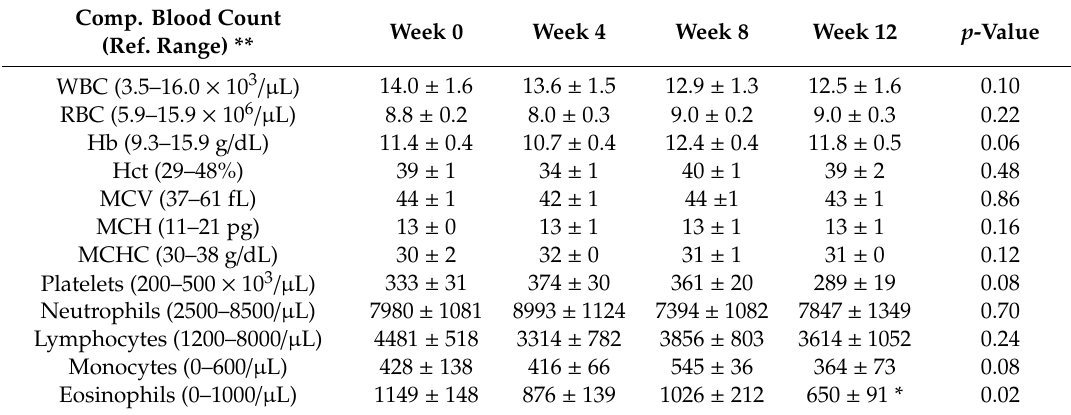
Table 5. Cat (n = 8) mean and SEM of complete blood counts immediately prior to (week 0), 4 weeks, 8 weeks and 12 weeks of an oral 2 mg / kg CBD dose twice daily using a CBD-rich hemp product. Comp. Blood Count